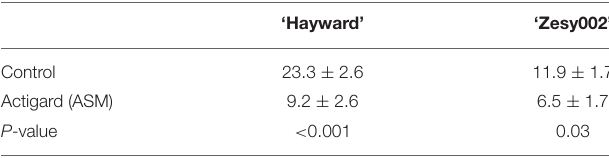
with Pseudomonas syringae pv. actinidiae .